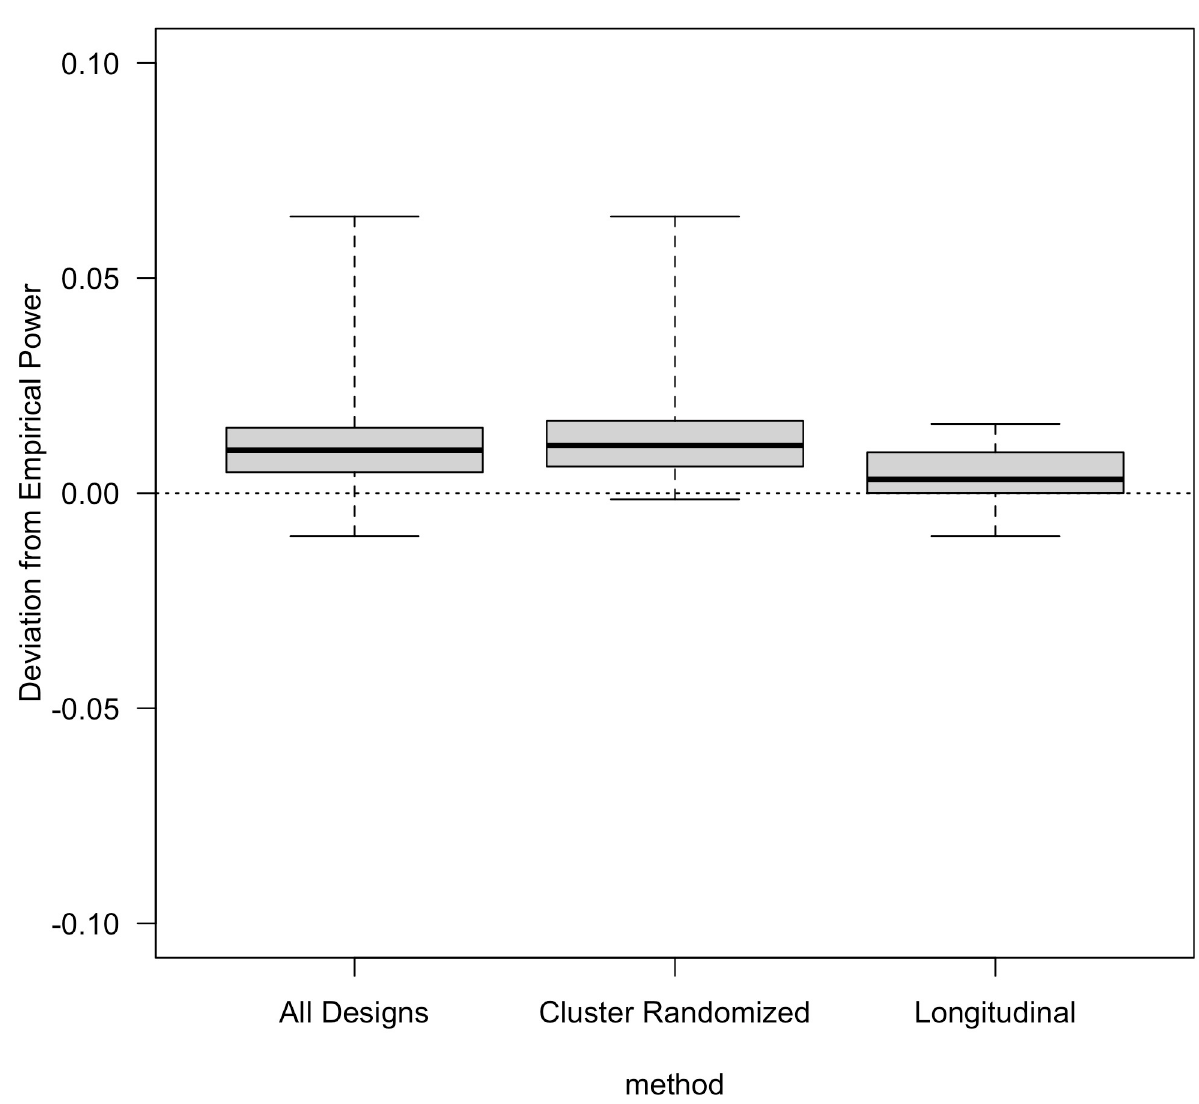
Fig 1. Power deviations for all designs, cluster randomized designs only, and longitudinal designs only. (center line, median; box limits, 1st and 3rd quartiles; whiskers, minimum and maximum).